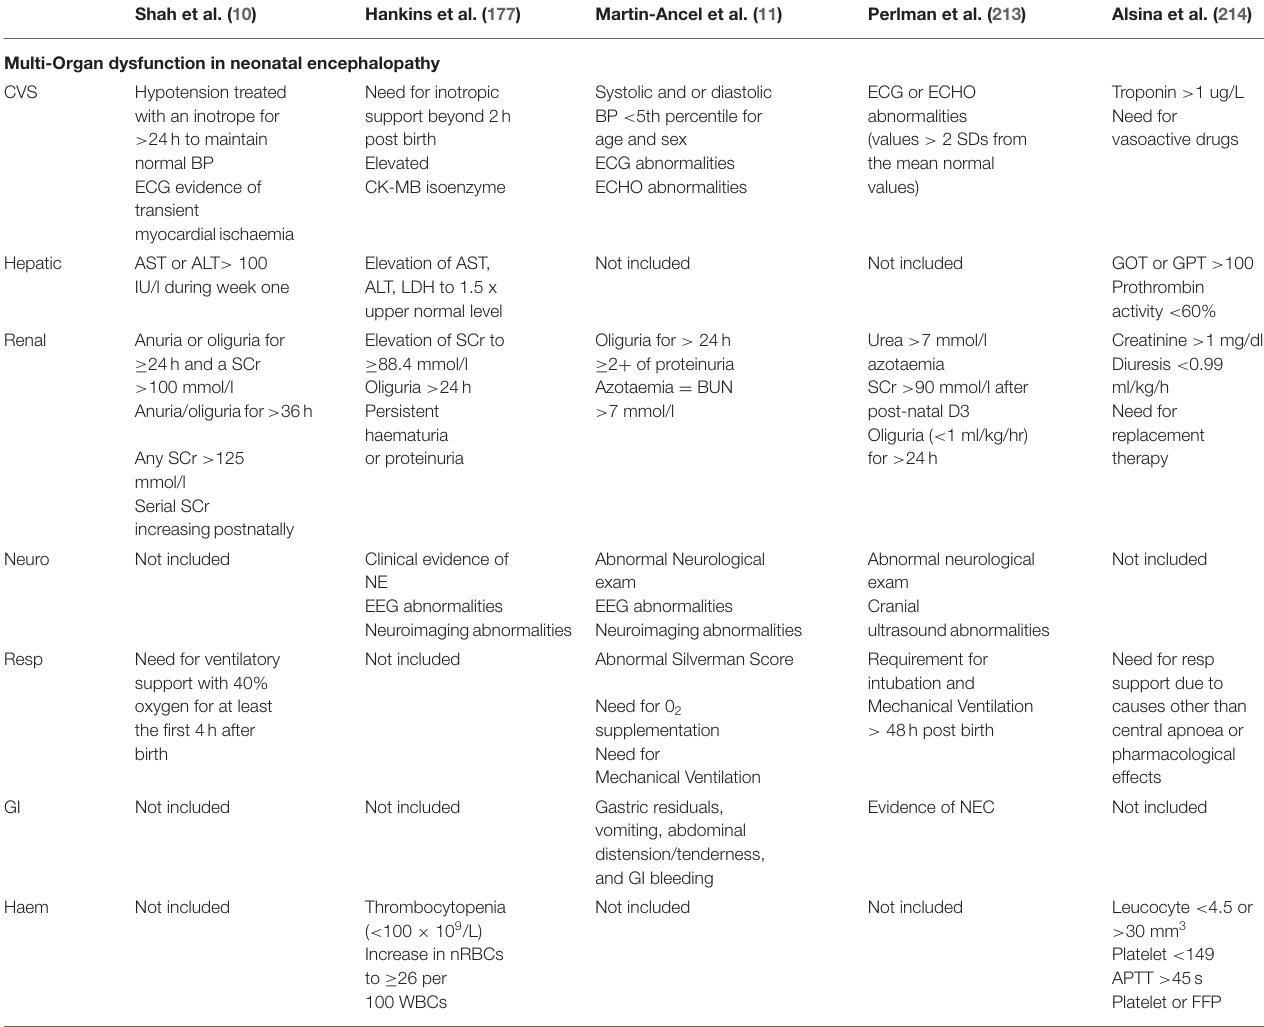
TABLE 1 | Comparison of definitions of Multi-Organ Dysfunction in Neonatal Encephalopathy. Shah et al.